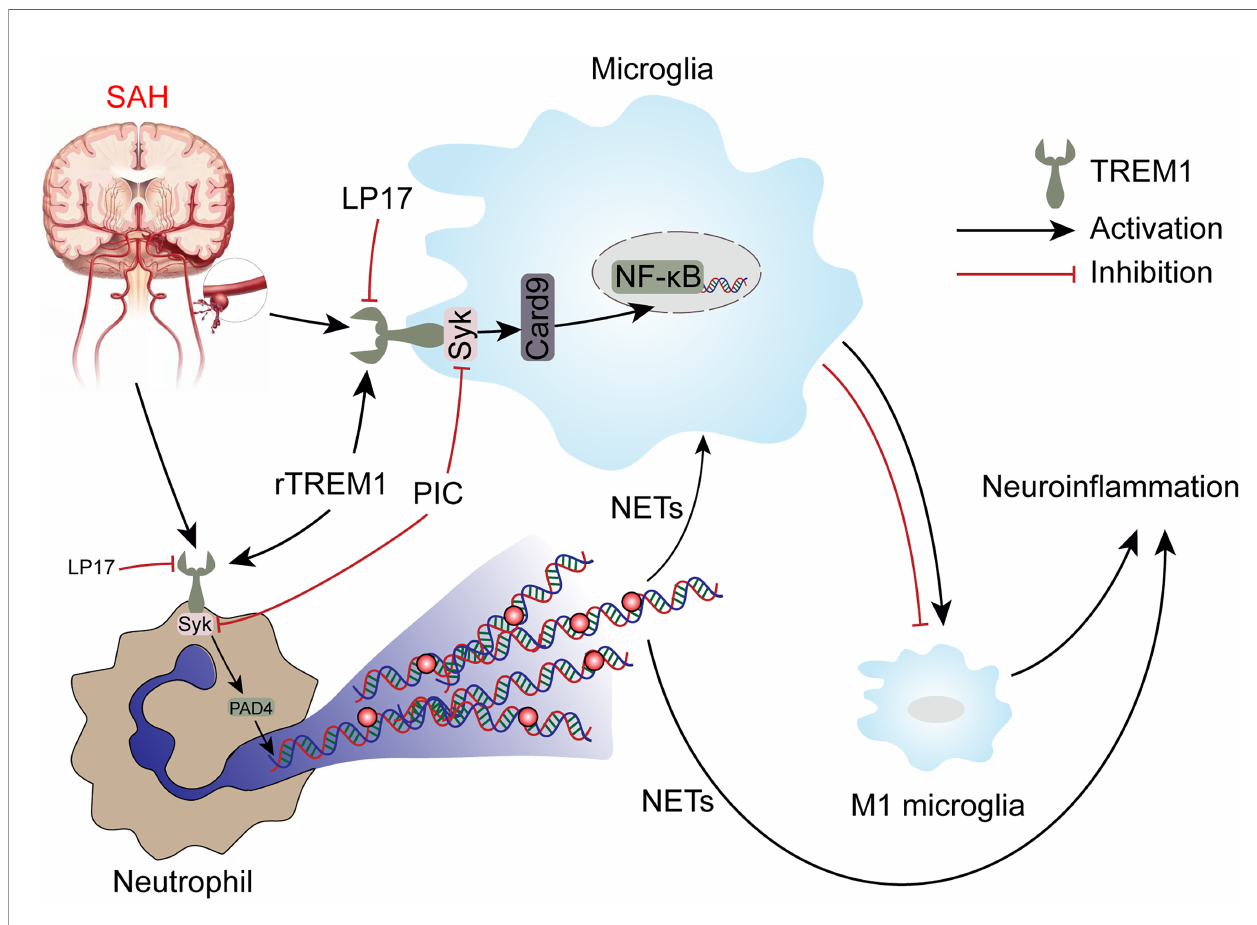
FIGURE 10 | Schematic mechanism of TREM-1 regulates post-SAH neuroin fl